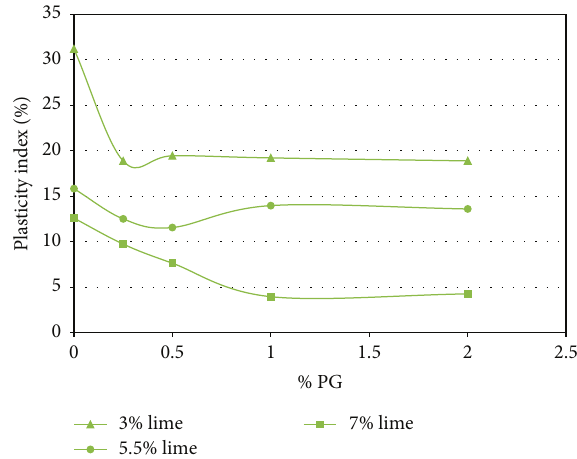
Figure 4: Effect of PG on the plasticity of 5.5% lime stabilized soil.